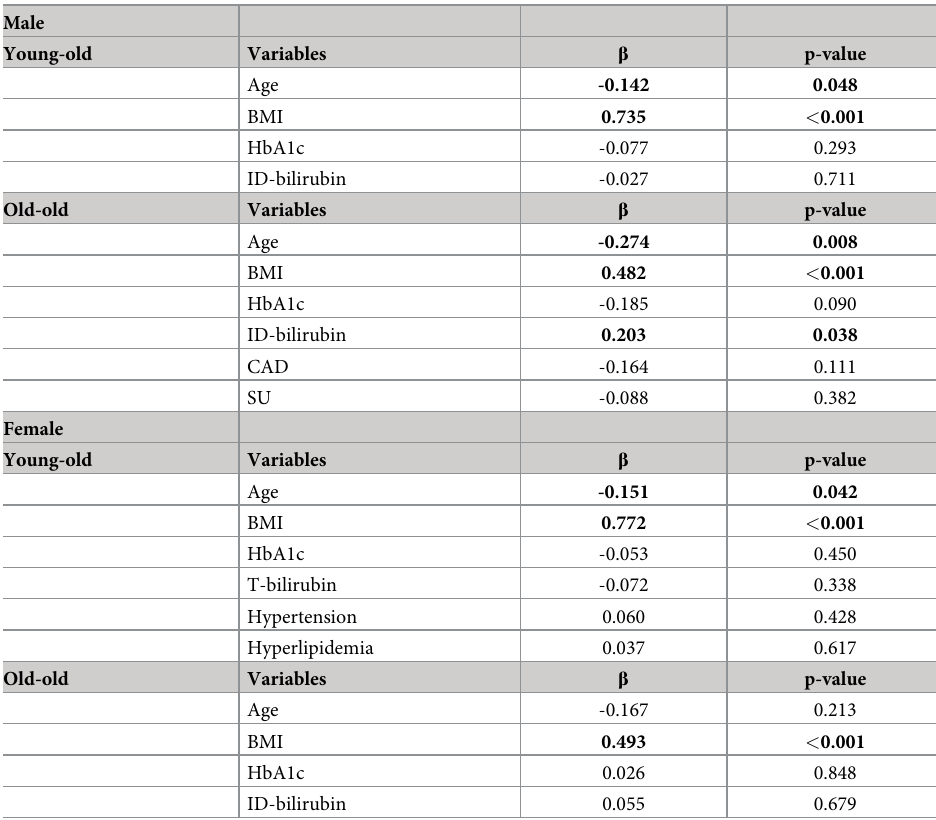
Table 4. Determinants for skeletal muscle mass index (SMI) evaluated by multivariate linear regression